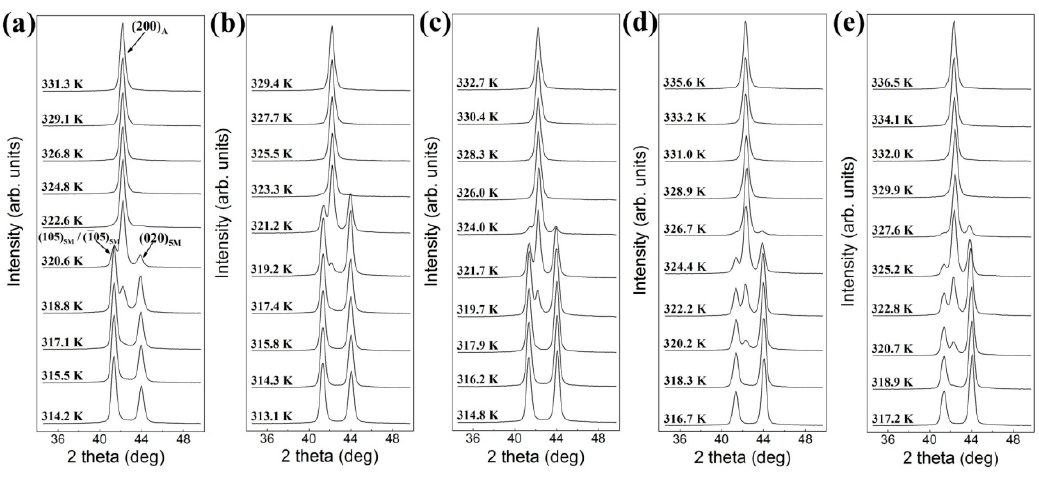
Figure 6. In-situ neutron diffraction patterns measured on cooling under the compressive load for directionally solidified Ni 50 Mn 28.5 Ga 21.5 alloy [38]: ( a ) 0 MPa (Cycle 1); ( b ) − 10 MPa (Cycle 2); ( c ) − 20 MPa (Cycle 3); ( d ) − 40 MPa (Cycle 4); and ( e ) − 50 MPa (Cycle 5).